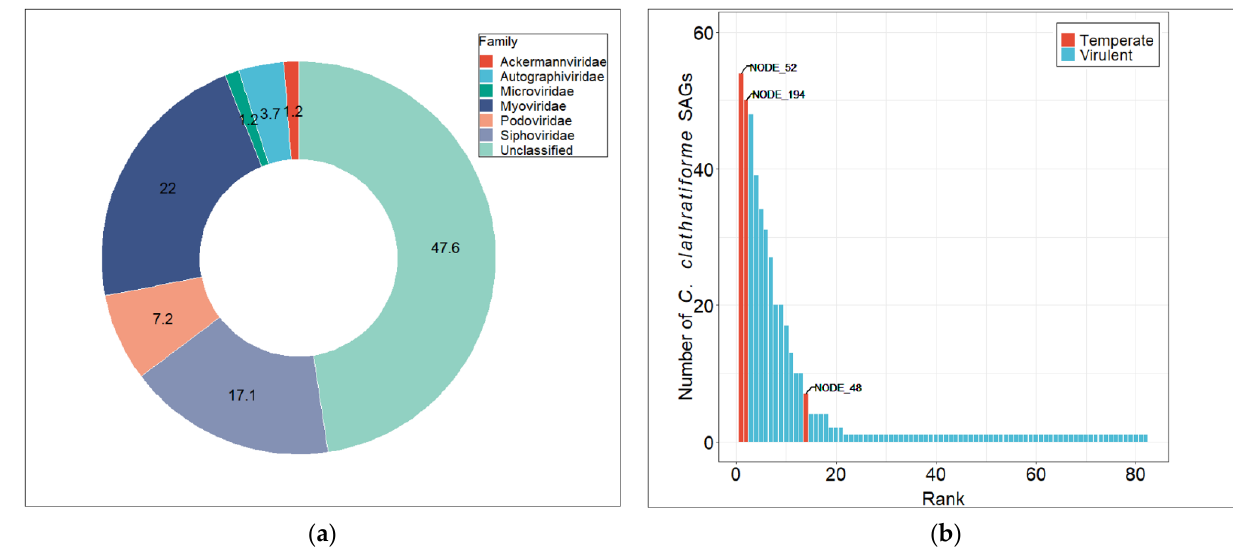
Figure 2. Taxonomic (Kaiju) classification ( a ) and distribution ( b ) of viral contigs recovered from 62 C. clathratiforme single amplified genomes (SAGs). Phage contigs were ordered by detection frequency among 62 C . clathratiforme SAGs.